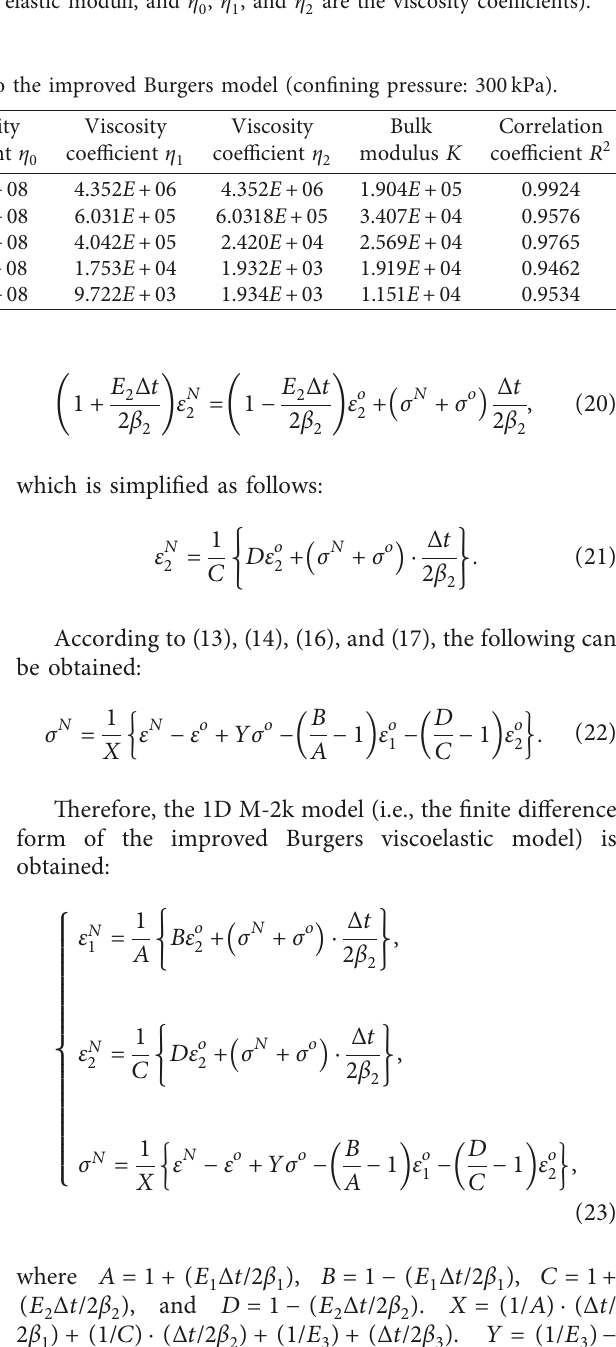
, E , and E are the elastic moduli, and η 0 1 2